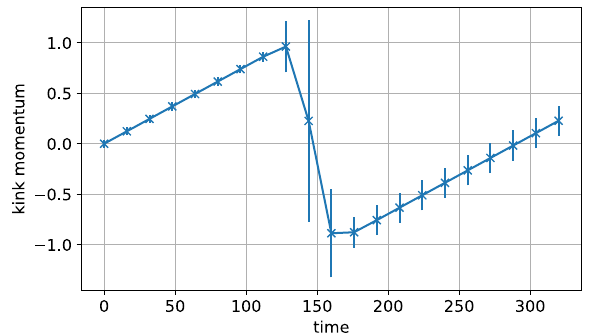
FIG. 24. Momentum of the kink in simulation (i) of the main text (Ising), computed from the projected wavefunction in the κκ ( 0,0 ) basis. The bond dimension is 128. Since the κκ ( 0,0 ) basis does not accurately capture the state when the kink is very close to the antikink, these data are not complete during the collision ( t ≈ 140). The error bars indicate the standard deviation of the momentum distribution.